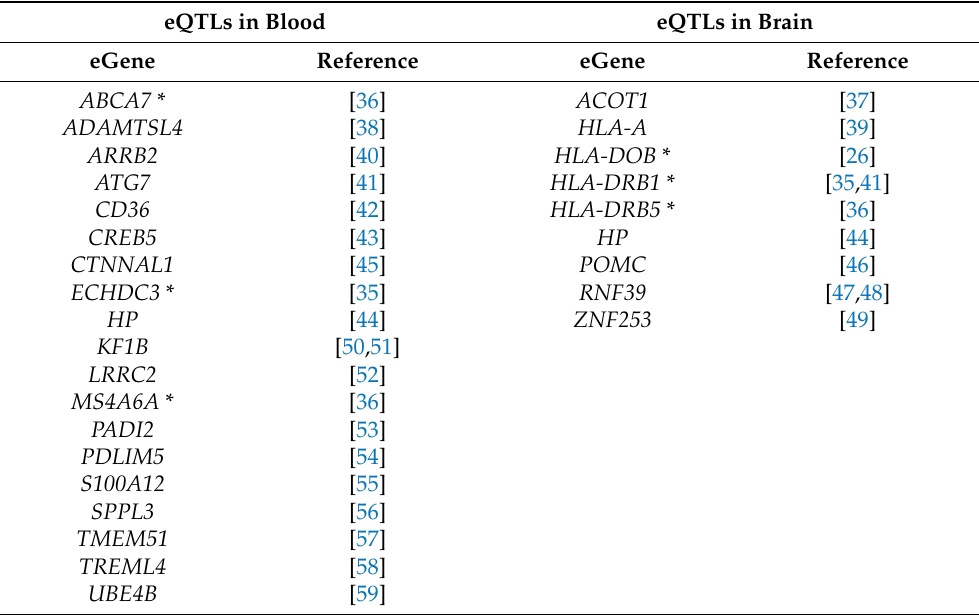
Figure 2. Overlap of significant genes in rare gene-level and common eQTLs in ( A ) the blood and ( B ) the brain. Table 5. Genes previously implicated in AD whose expression is influenced by both rare and common